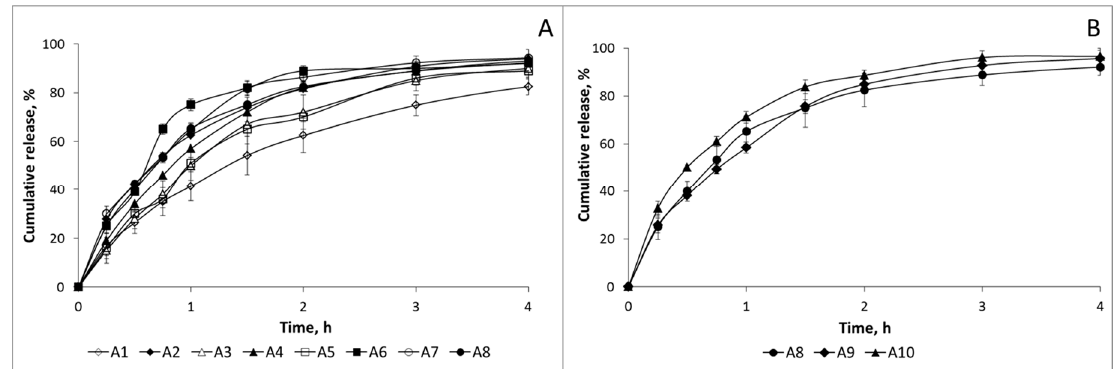
Figure 4. Release pattern in simulated gastric fluid (SGF) at 37 °C. ( A ) Comparison of formulations with chitosan (CS):TPP ratio 100:30; ( B ) Comparison of formulations with different CS:TPP ratio. Open symbols, chitosan CS-1; close symbols, chitosan CS-2.